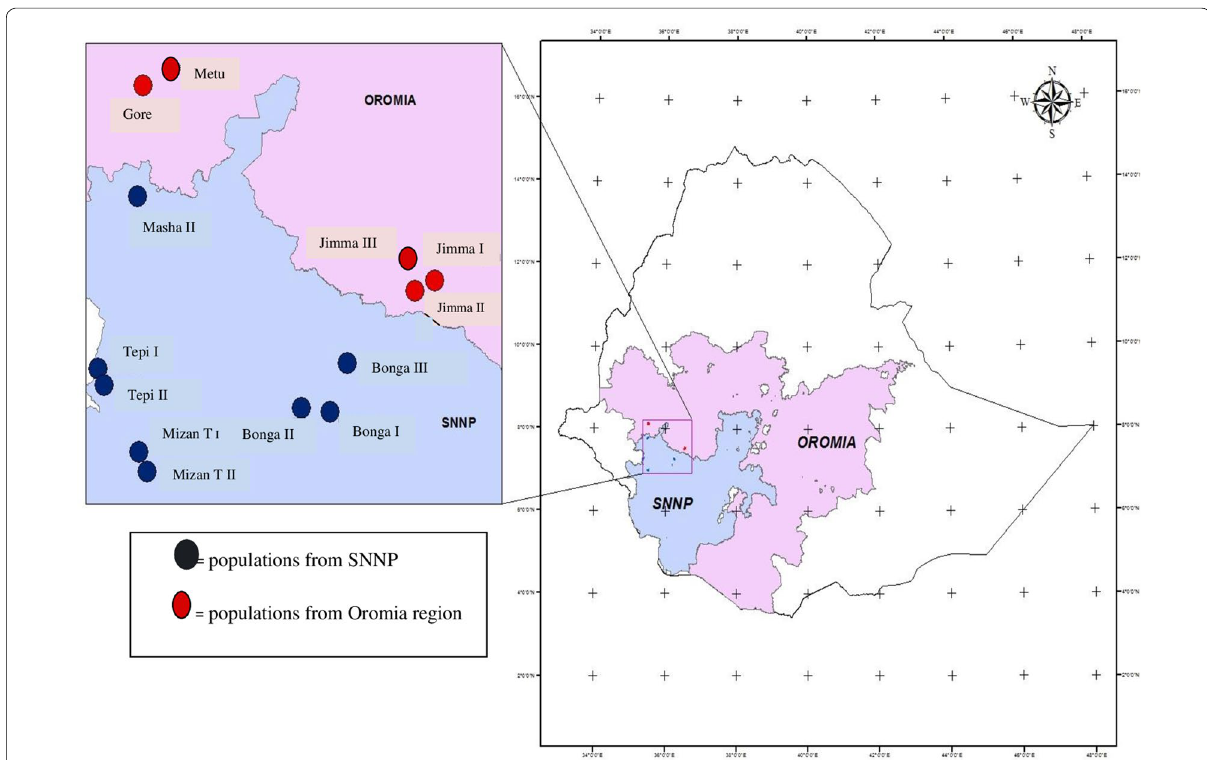
Fig. 1 Regional map of Ethiopia showing the cultivated korarima collection sites ( SNNPR Southern Nations, Nationalities, and People’s Region). The map was constructed based on geographic coordinates and elevation data gathered from each collection sites using global positioning system